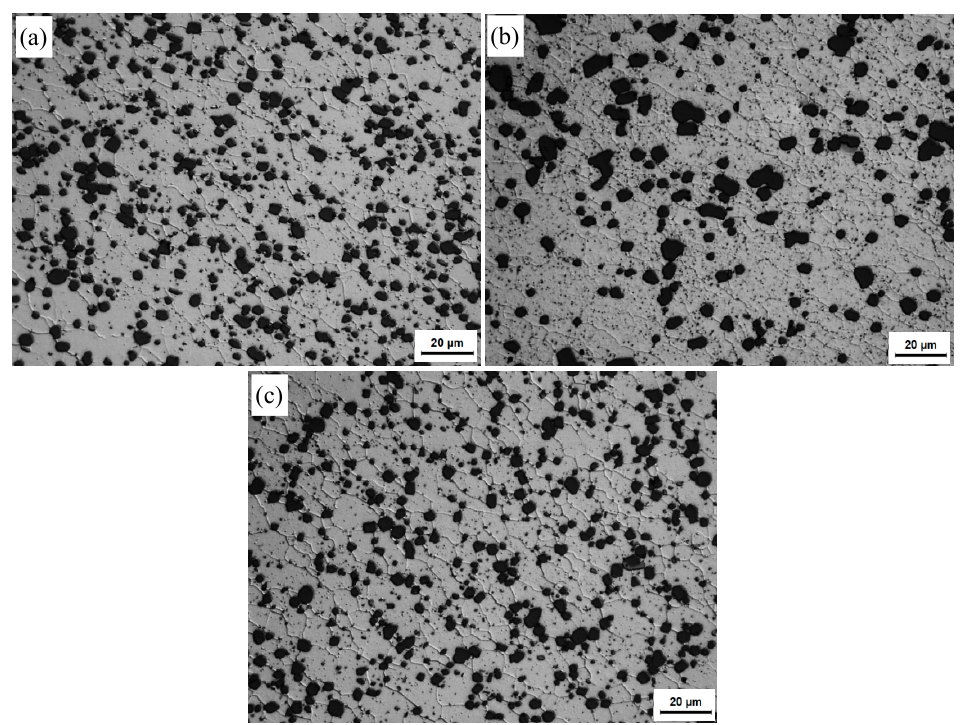
Figure 11. Optical microstructures at the thermo ‐ mechanically affected zones (TMAZs) of FSW joints under different states: ( a ) T1; ( b ) T4; ( c ) T6.